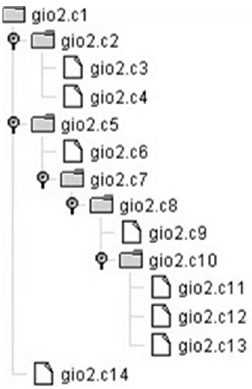
Figure 1. Tree-shaped representation of the Table 3 formalism.